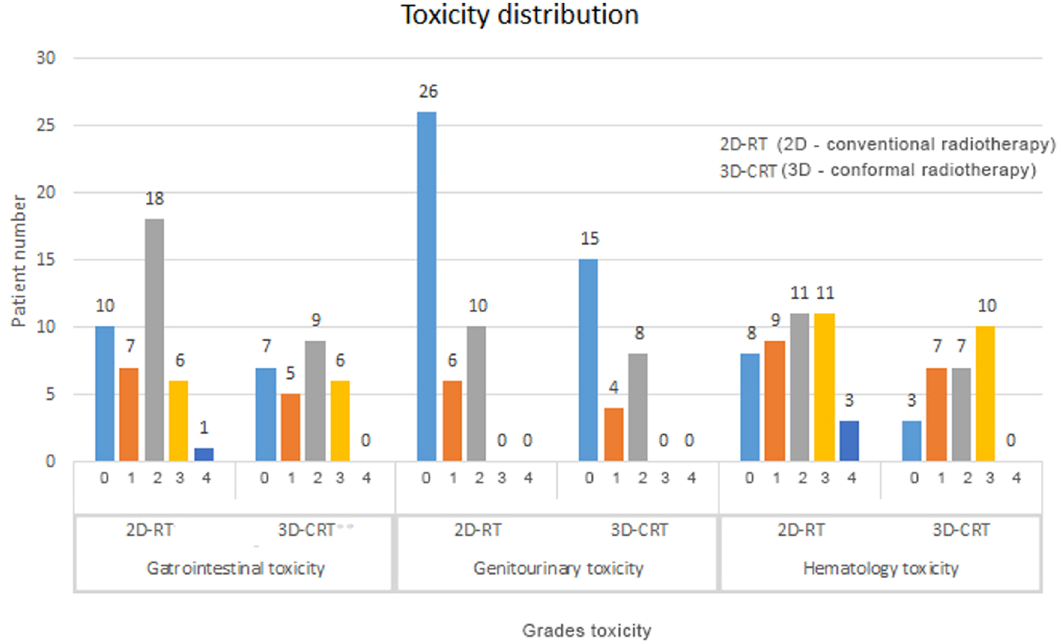
Figure 1: Distribution of acute radiation toxicity depending on radiotherapy